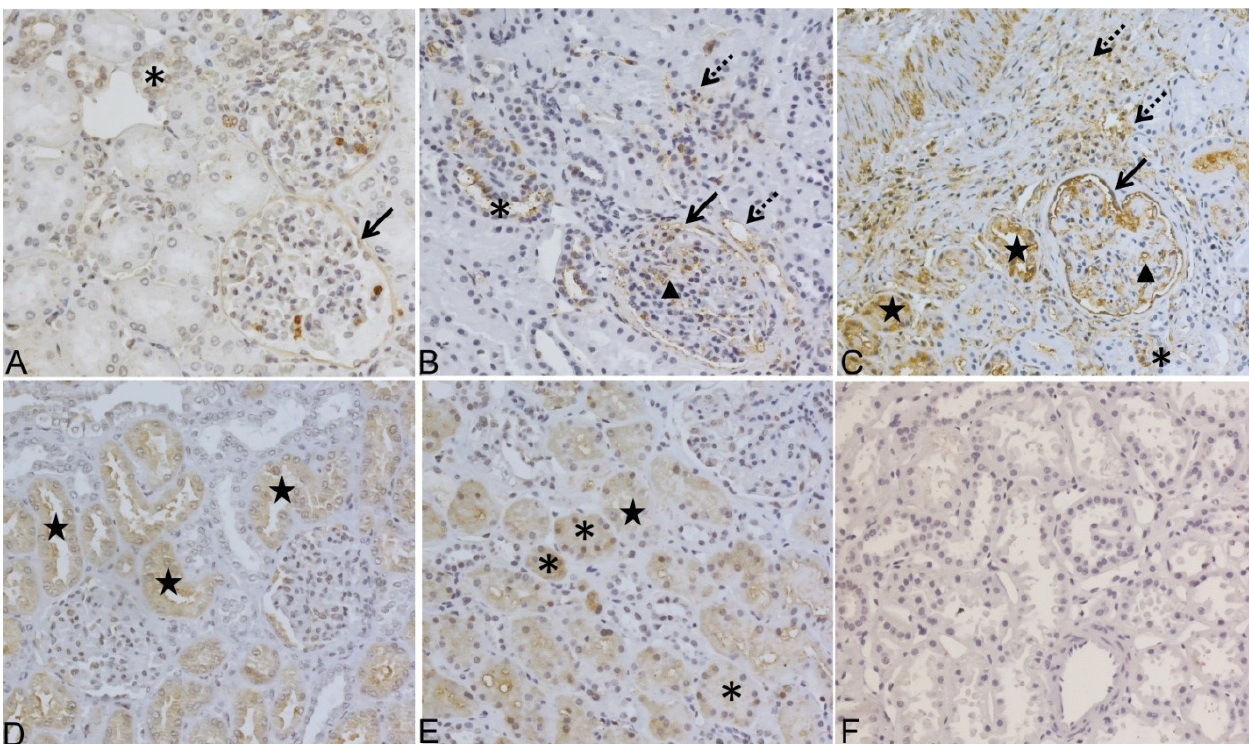
Figure 3. ADAMTS-4 and BMP-1 expression analyses by immunohistochemistry (IHC) in native kidney tissue biopsy samples (NKB) from patients with chronic kidney disease (CKD) in different stages of kidney failure. ( A ) Representative staining of ADAMTS-4 in control without CKD: positive in DT and BC; ( B ) representative staining of ADAMTS-4 in early stage of CKD (Stage 2) positive in GC, peritubular capillaries (PTC), mild fibrosis in interstitial area INT, BC, and DT; ( C ) representative staining of ADAMTS-4 in advanced stages of CKD (Stage 4) positive in all six analyzed kidney areas (GC, PTC, INT, PXT, DT, and BC); ( D ) representative staining of BMP-1 in control without CKD: positive only in PXT and ( E ) in early stage of CKD (Stage 2), positive in DT and PXT with no labelling find in glomerulus; ( F ) secondary antibody only control. Original magnification 200×. DT, asterisk; BC, black arrow; GC, black arrow head; PTC, INT, dashed arrow; PXT, black star.